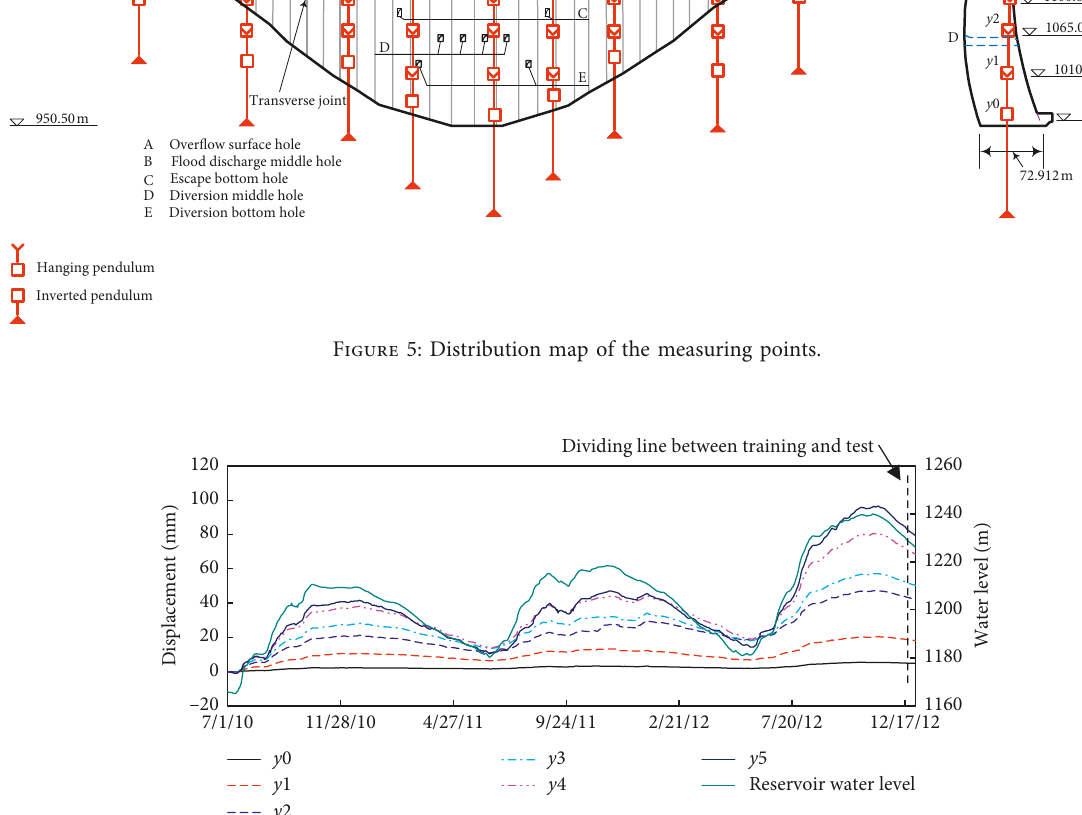
Figure 6: Time evolution of measuring point displacement and reservoir water level.